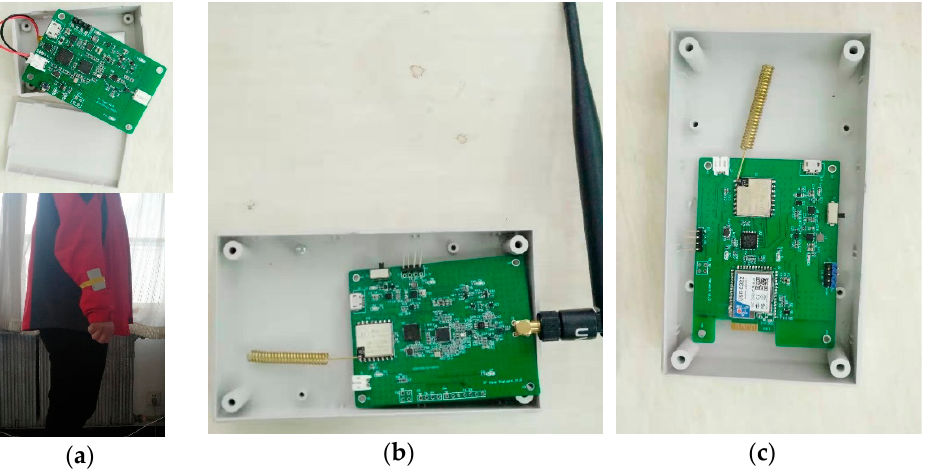
Figure 7. Three hardware devices for the hybrid localization system: ( a ) TN; ( b ) BN; ( c ) middleware.